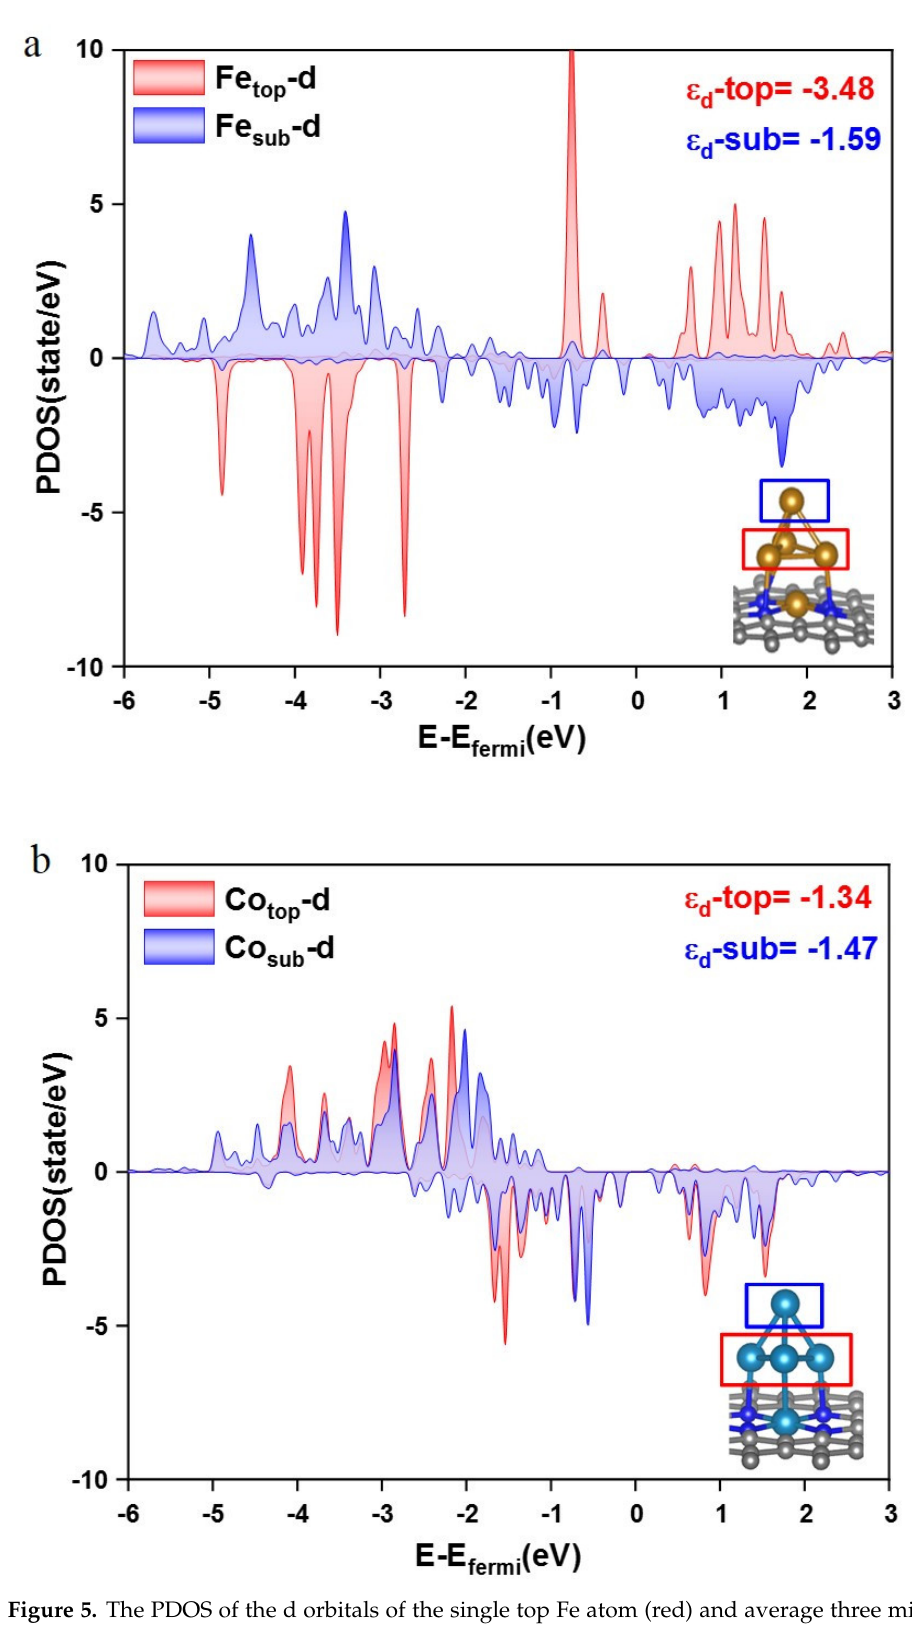
Figure 5. The PDOS of the d orbitals of the single top Fe atom (red) and average three middle Fe atoms (blue) in Fe 5 -NC ( a ), and the PDOS of the d orbitals of the single top Co atom (red) and average three middle Co atoms (blue) in Co 5 -NC ( b ).